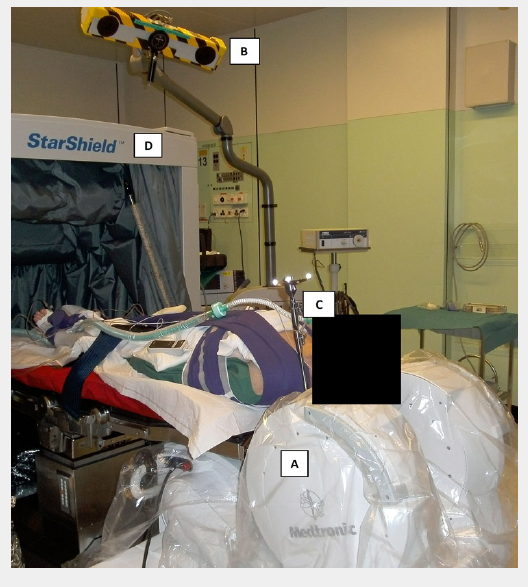
Setup for iMRI-guided transsphenoidal surgery. The patient is positioned in supine position with the head fixed in a MRI-compatible head clamp. Since the PoleStar ® device (A; Medtronic, Inc.) needs to be placed very close to the shoulders, gentle traction is applied by soft bandages. Two LED cameras (B) record the position of a tracking frame (C) which is fixed to the head clamp and referenced to the surface of the patient’s face for frameless stereotactic navigation by the StealthStation TREON ® system (Medtronic, Inc.). During the scans, the PoleStar ® device is moved into scanning position and the StarShield Portable RF Shield ® (D; Medtronic, Inc.) is closed. Thereby, electronic devices may remain turned on during scanning and there’s no need for full room radio frequency